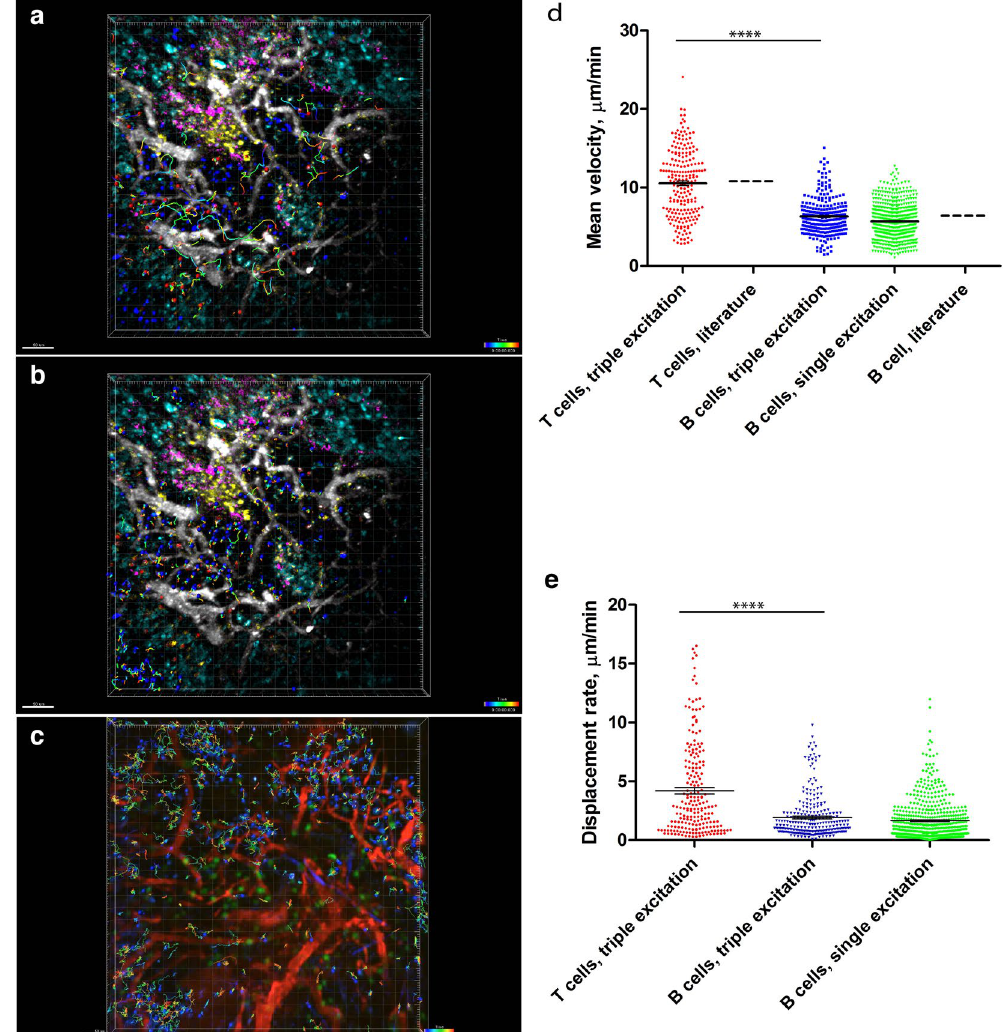
Figure 7. Naïve B and T helper cell motility patterns are similar in conventional and multiplex in vivo imaging, respectively, during GC reactions. ( a , b ) SIMI-unmixed time-lapsed 3D fluorescence images (500 × 500 × 40 µ m³) as described in Fig. 6, with tracked CD4 + T and naïve B cells. The cell tracks are depicted as rainbow colored lines. We performed triple two-photon excitation at 850 nm (Ti:Sa), 1230 nm (OPO) and virtually at 1005 nm. ( c ) Time-lapsed 3D fluorescence images (500 × 500 × 30 µ m³) in the lymph node of an anesthetized mouse, at day 7 after NP-CGG immunization. Naïve B cells labelled by Hoechst are depicted in blue, B1-8 GFP cells (GCs cells) are depicted in green and blood vessels labeled by rhodamine-dextran are shown in red. In this case, we performed a single two-photon excitation at 930 nm (Ti:Sa). Mean velocity distribution ( d ) and the displacement rate ( e ) of naïve B- and T helper cells, respectively, is significantly different, as previously reported. The absolute values of the mean velocity of both naïve B cells and T cells match the published values for B and T cell velocities 9 , depicted in graph ( d ). Additionally, both the mean velocity and the displacement rate of naïve B cells after triple two-photon excitation (with Ti:Sa and OPO), obtained from ( a , b ), are the same as the values measured after single two-photon excitation (with only Ti:Sa), obtained from ( c ), as indicated in the graphs ( d ) and ( e ). Mann-Whitney non-parametric tests were used for statistical analysis of the data. ( * p < 0.05, ** p < 0.01, *** p < 0.001, **** p < 0.0001). Scale bars, 50 μ